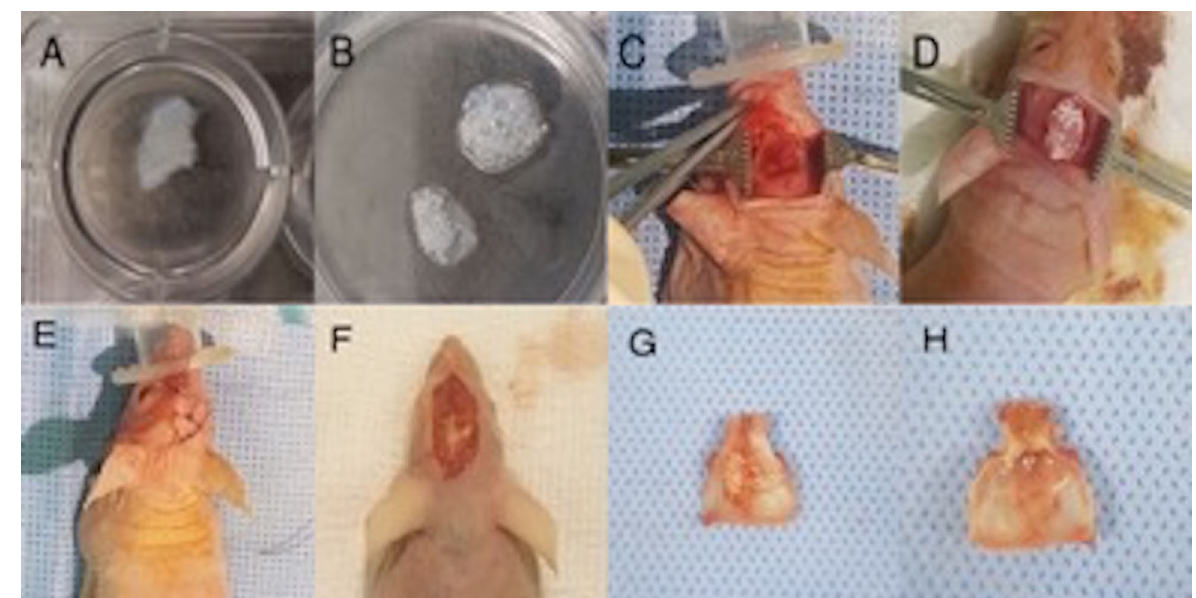
Fig. 1 Images showing the decellularised skeletal muscle tissue adapted into the created defect of the nude mouse calvarium. A The muscle graft was decellularised and prepared for experiments. B The muscle was treated using SCPC bone cement. C A critical defect was created in the mouse calvarium. D The treated muscle was adapted into